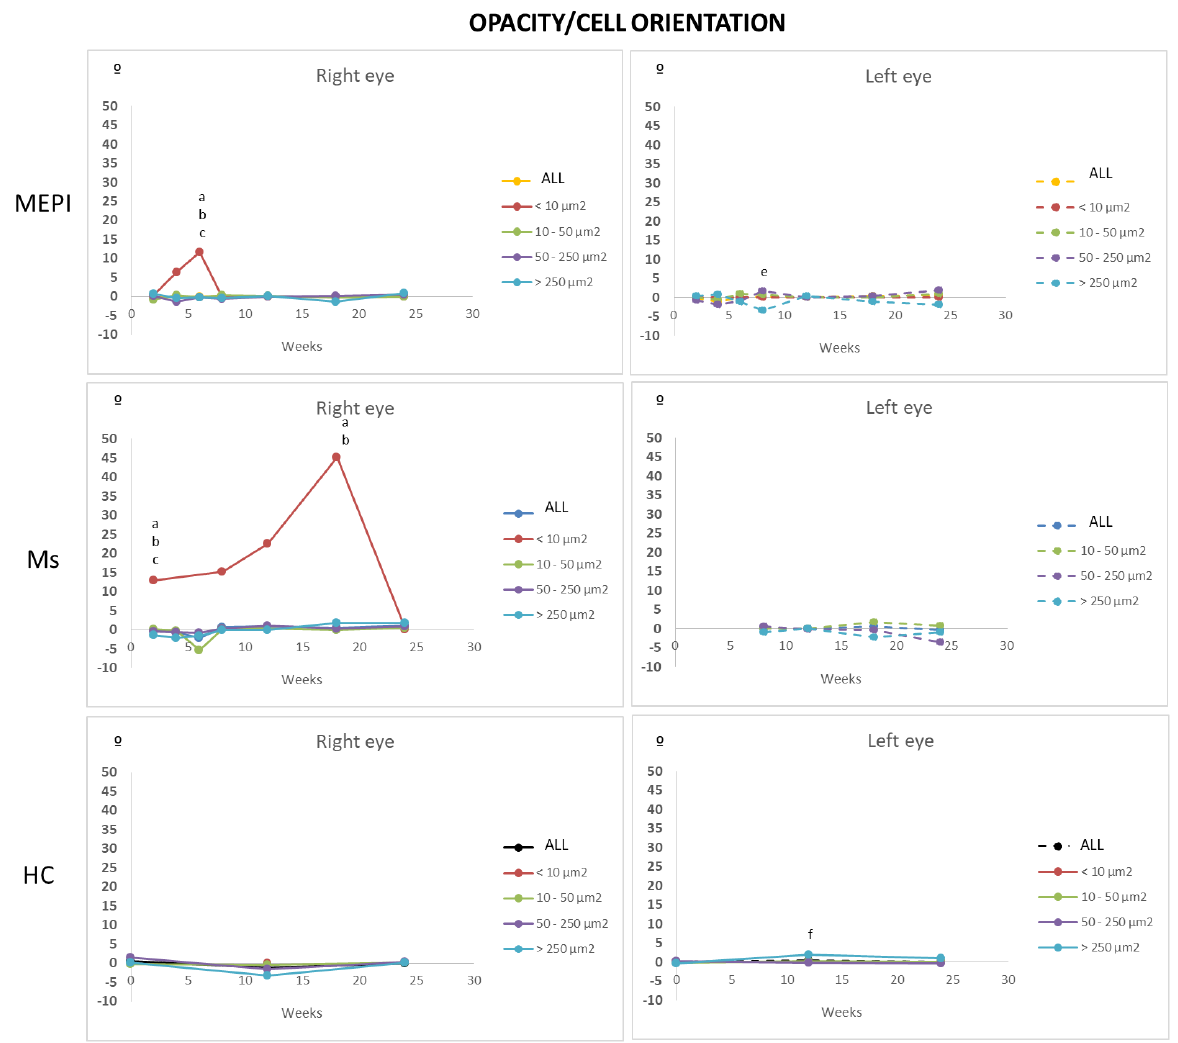
Figure 12. Mean orientation of vitreous opacity detected using OCT, according to size, in both glaucoma models and healthy controls. In vivo analysis of the change in opacity/cell direction for motility. Abbreviations: MEPI: model induced by sclerosing the episcleral veins; Ms: model induced by injecting microspheres into the anterior chamber; isolated cells: opacities < 10 microns 2 (group 1); non-activated cells: 10–50 microns 2 (group 2); activated cells: 50–250 microns 2 (group 3); cell complexes: > 250 microns 2 (group 4). Statistically significant differences ( p < 0.05) were highlighted with alphabetic markers as follows: a (group 1–group 2); b (group 1–group 3); c (group 1–group 4); d (group 2–group 3); e (group 2–group 4); f (group 3–group 4);